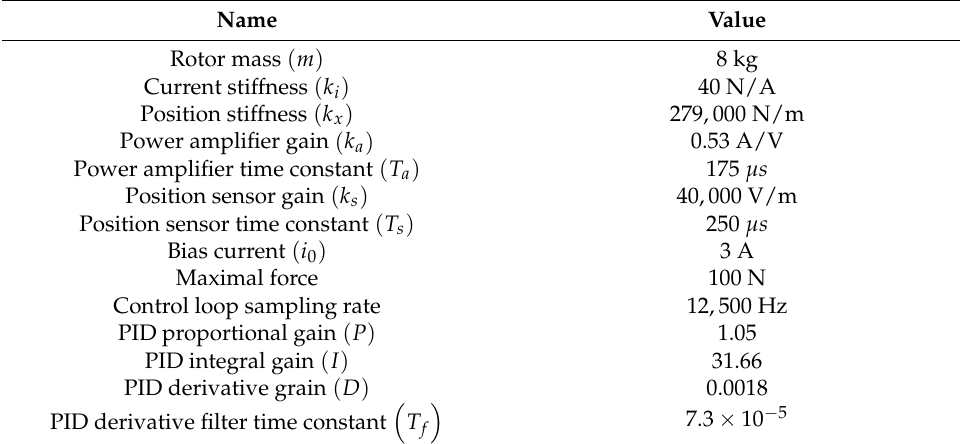
Figure 7. Simulation block scheme. Table 1. Parameters of the AMB rotor system and PID